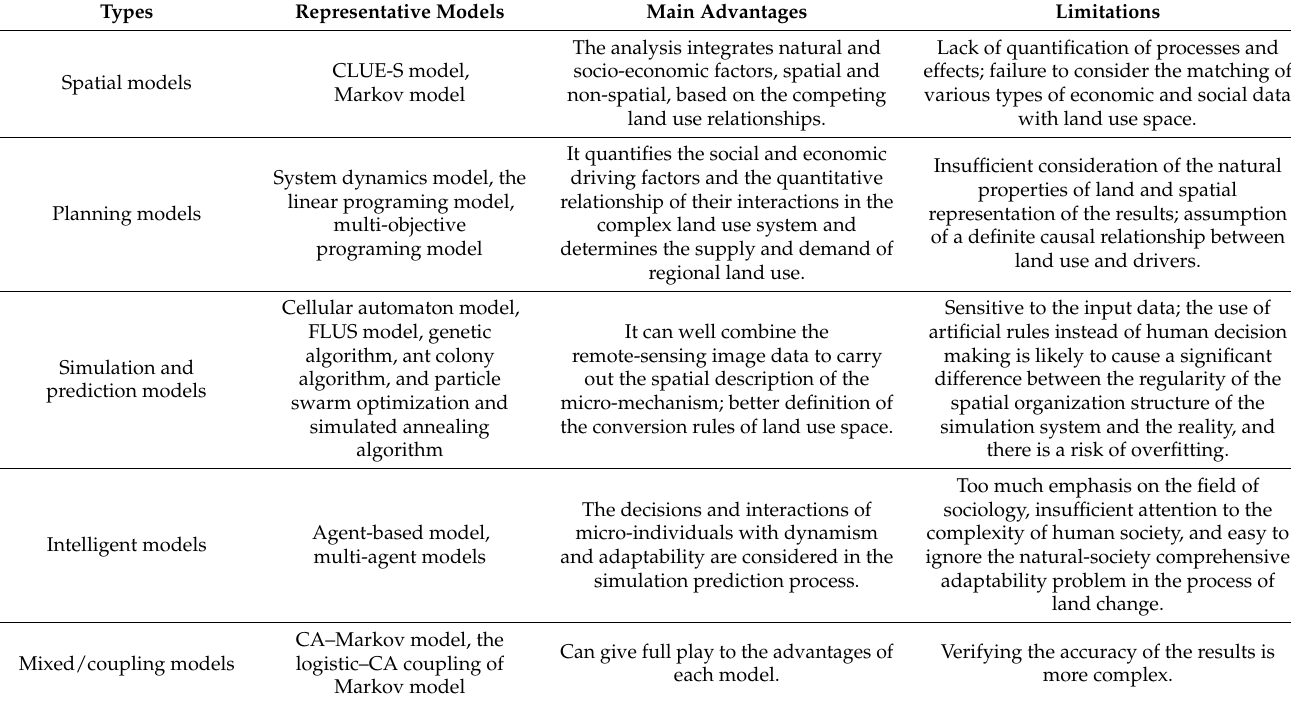
Table 1. Simulation and prediction models for spatial pattern of land use